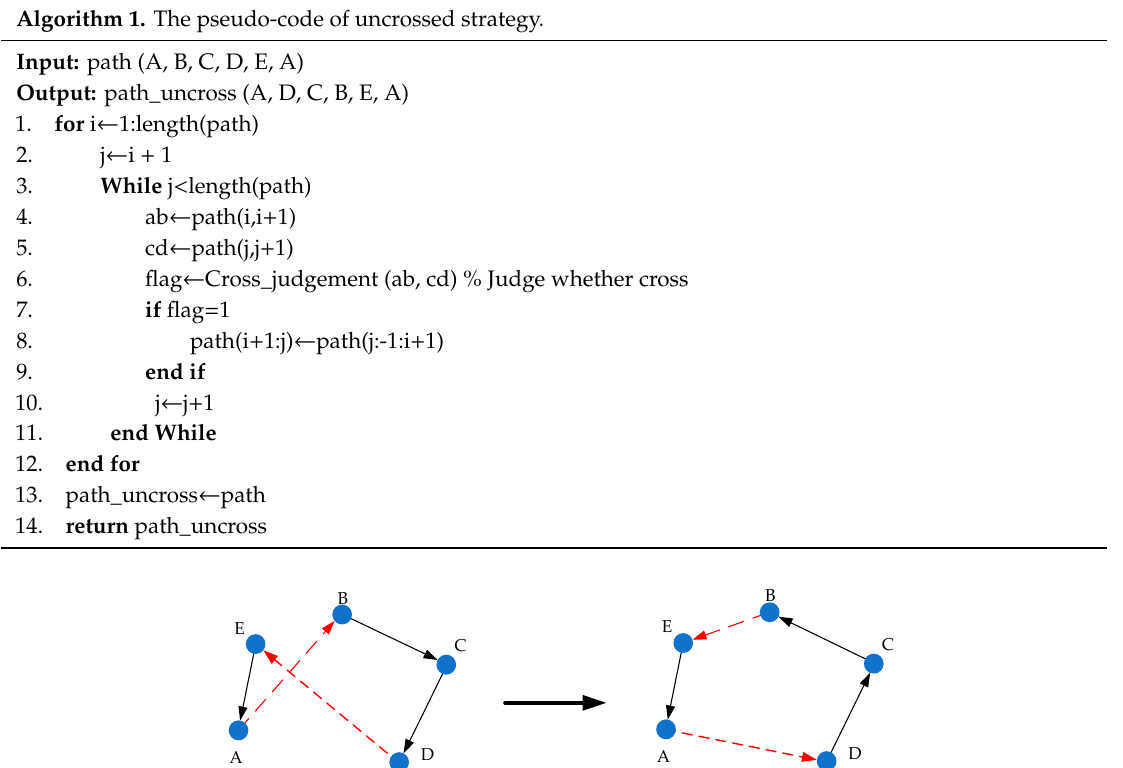
Algorithm 1. The pseudo-code of uncrossed strategy.